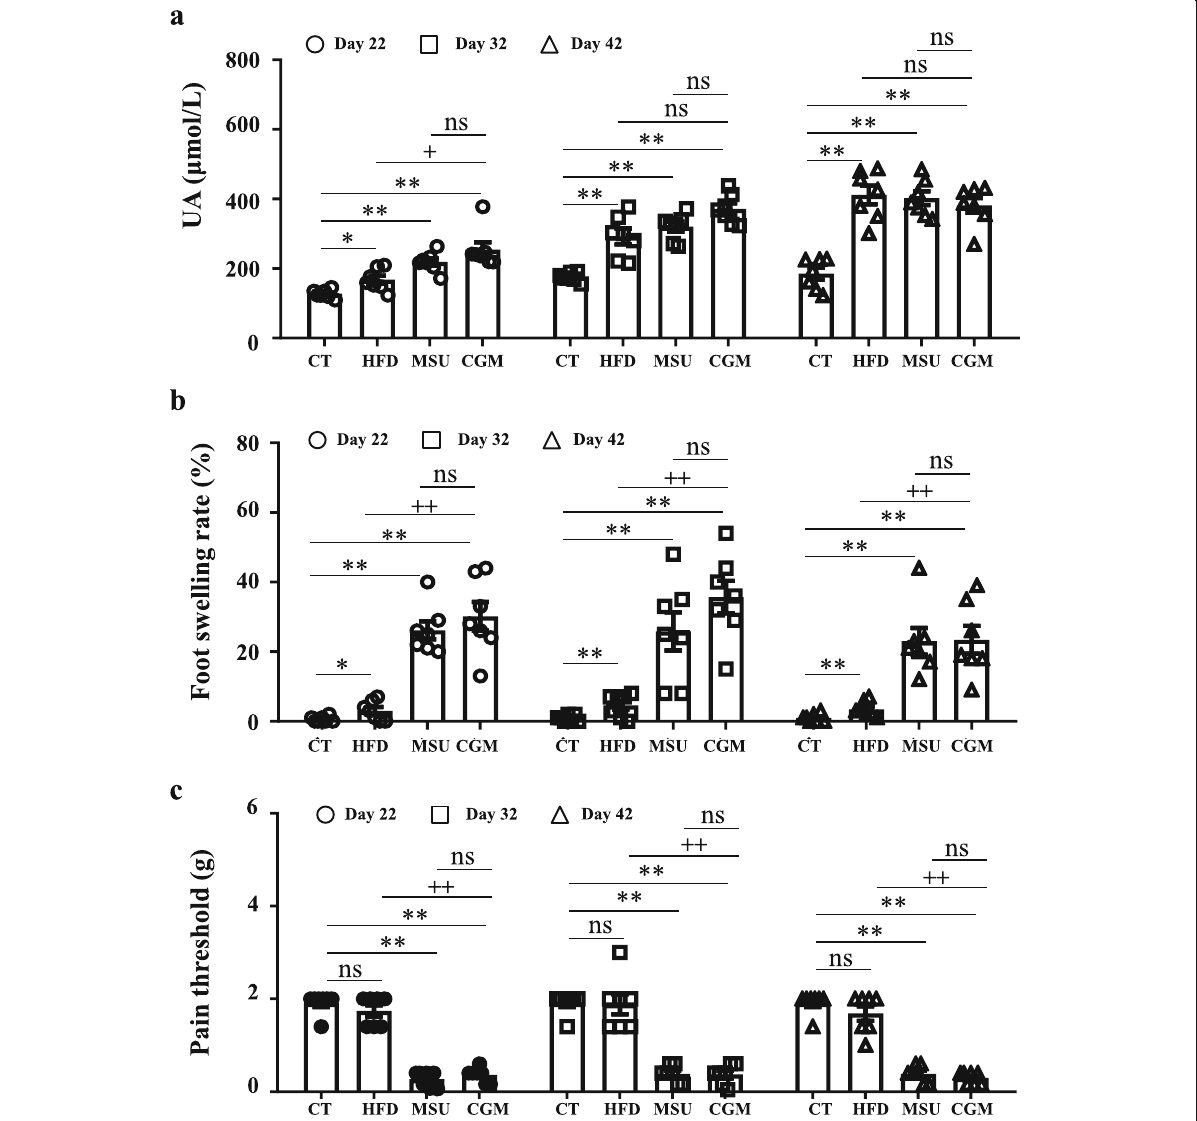
Fig. 1 Gout symptoms of mice in the four groups. Serum uric acid ( a ); foot swelling ( b ); pain threshold ( c ). “ ns ” represents not significant; “ * ” represents p < 0.05 in comparison with CT; and “ ** ” represents p < 0.01 in comparison with CT; “ + ” represents p < 0.05 in comparison with CGM; and “ ++ ” represents p < 0.01 in comparison with CGM. UA: uric acid; CT: control group; HFD: hyperuricaemia model; MSU: acute gout